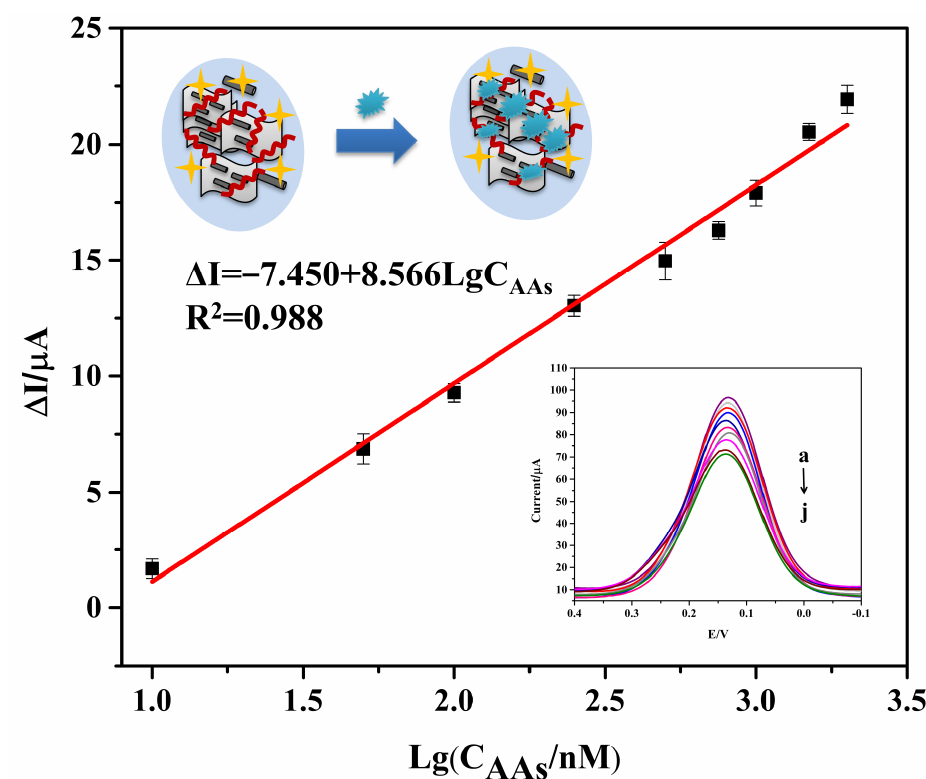
Figure 5. Linear curve of aptasensor for AAs determination, from a to j: 0, 10, 50, 100, 250, 500, 750, 1000, 1500 and 2000 nM.